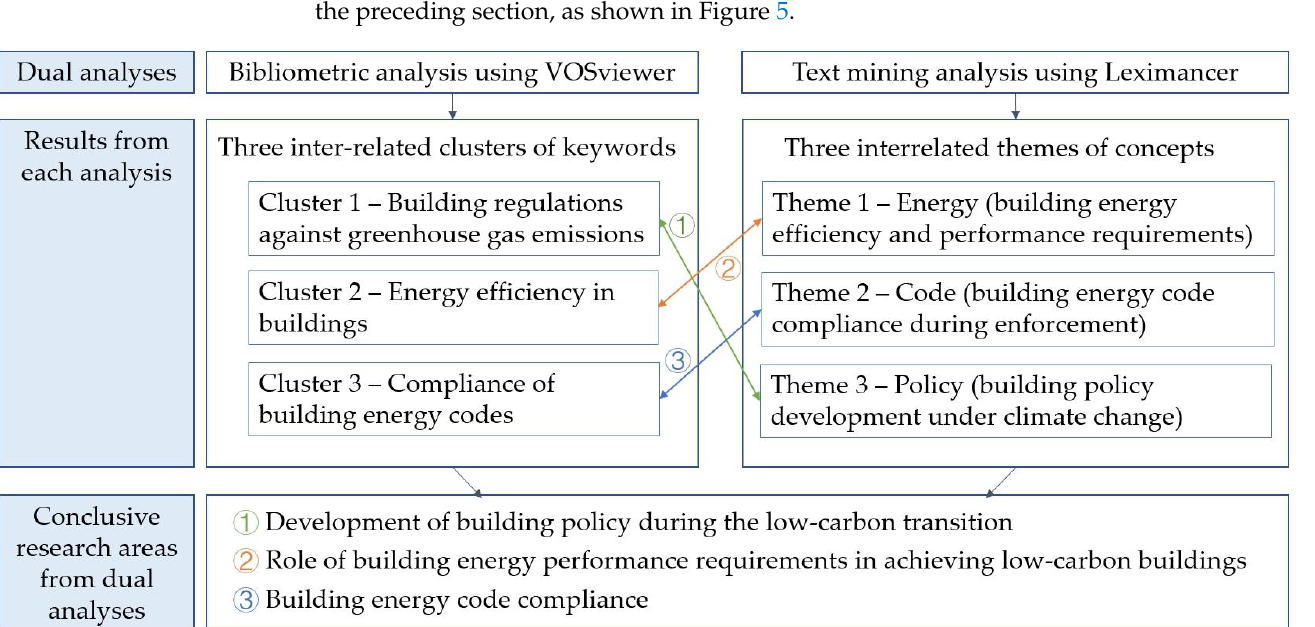
Figure 5. Derived research areas in the reviewed paper-set based on combined analyses .